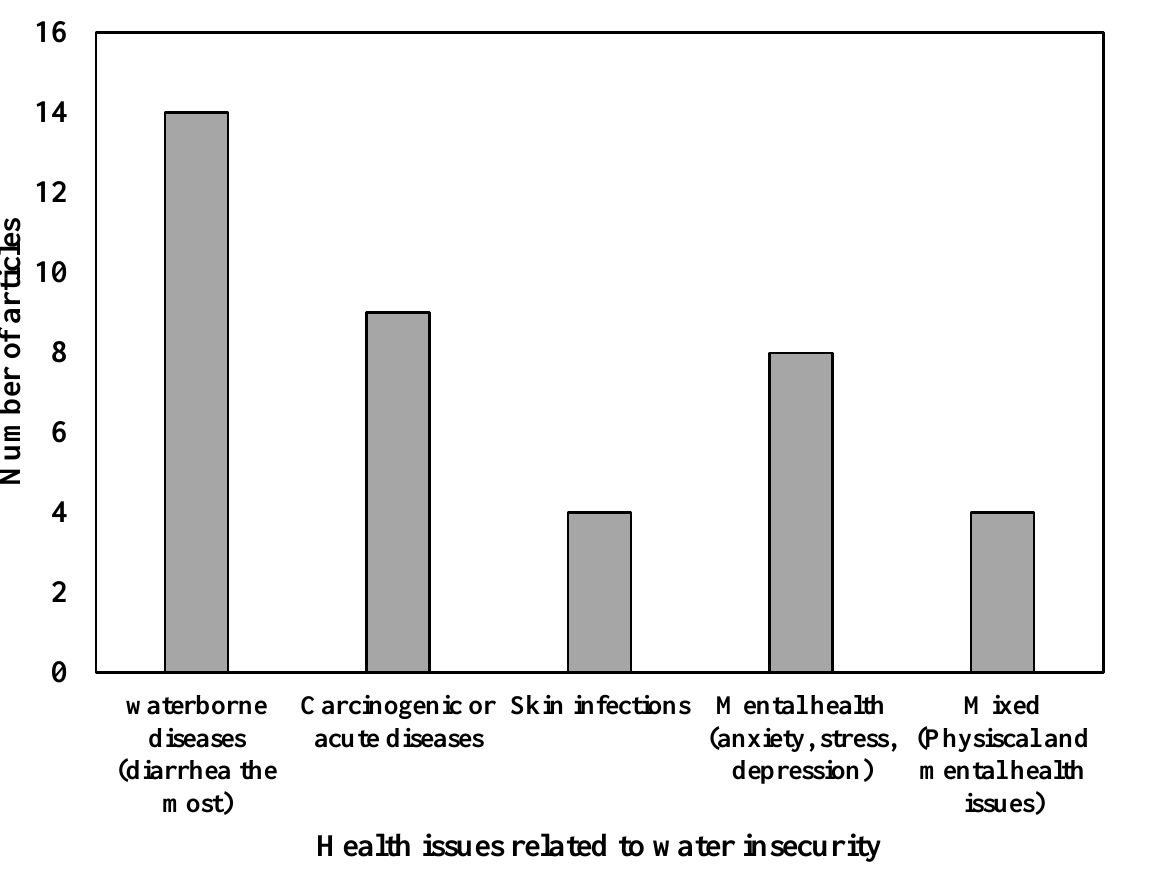
Figure 7. Summary of direct health issues related to water insecurity found in reviewed papers.